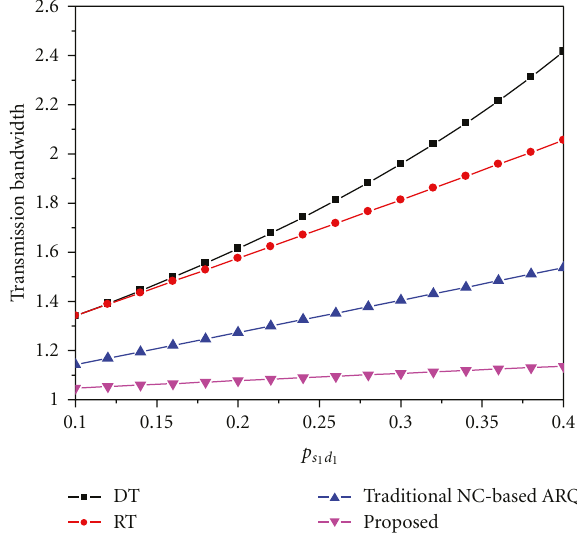
Figure 6: Transmission bandwidth of di ff erent protocols over p p p s 1 d 1 = s 2 d 2 with s 1 d 2 = = p rd = 0 . and p rd 1 2